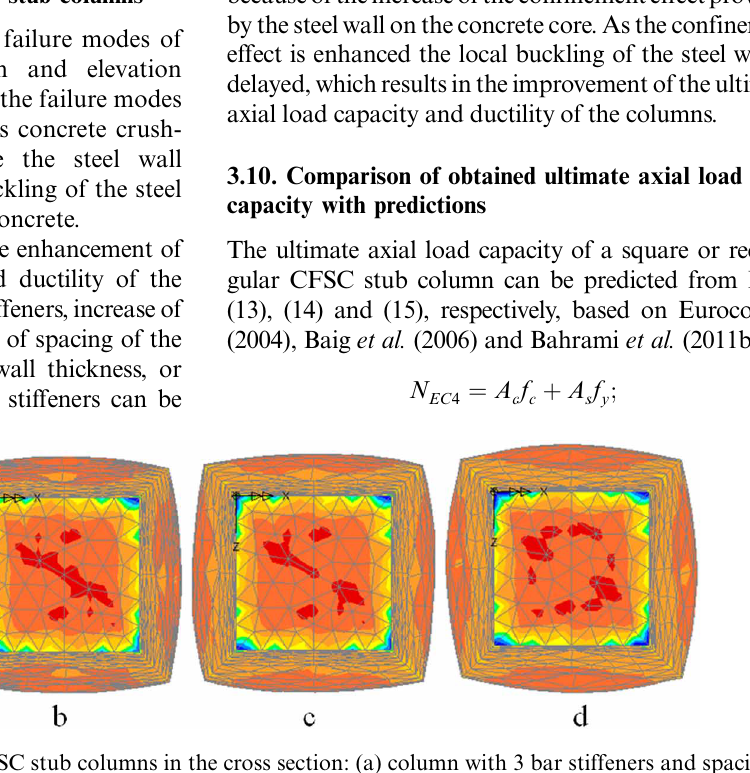
Fig. 17. Typical failure modes of the CFSC stub columns in the cross section: (a) column with 3 bar stiffeners and spacing of 50 mm; (b) column with 4 bar stiffeners and spacing of 100 mm; (c) column with 3 bar stiffeners and spacing of 150 mm; (d) column with 4 bar stiffeners and spacing of 150 mm